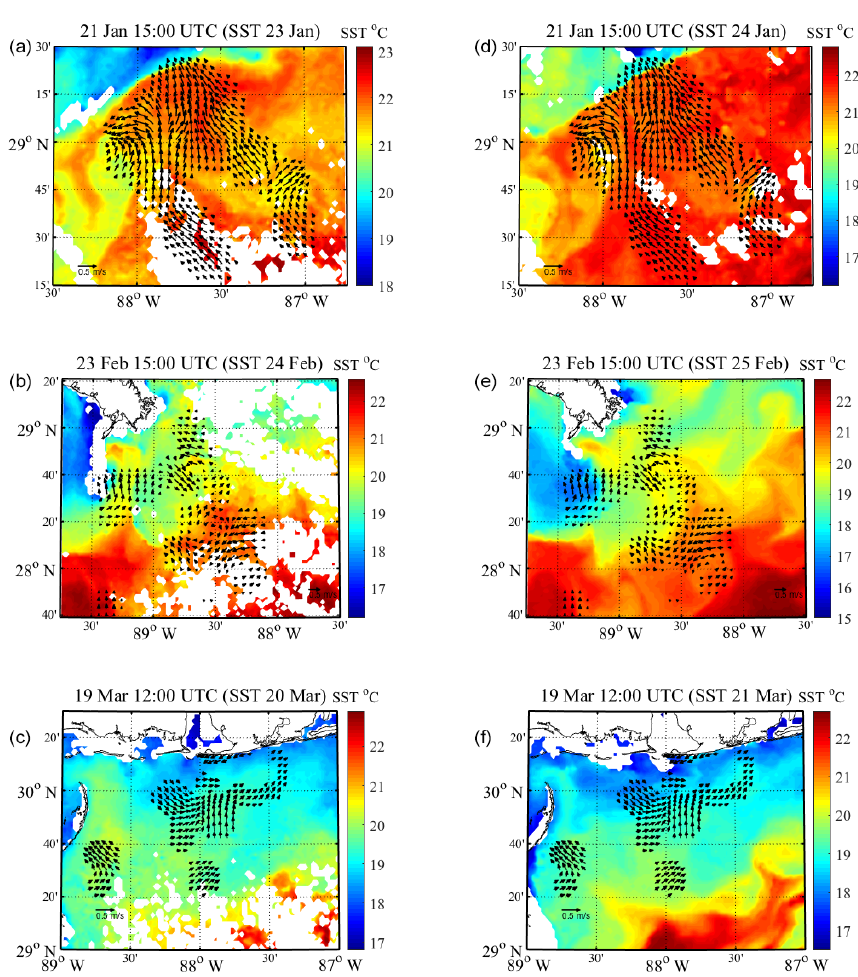
Figure 7. Eulerian velocity fields of the regional circulation that preceded each high wind event, created using LAVA for drogued drifters in the area. Also plotted are 24h averages of Aviso SST data during (a, b, c) and after (d, e, f) each high wind event. Titles of each plot list the beginning of each hour over which the velocity field was created from drifter trajectories and the day corresponding to the Aviso SST data. The 24h averages, produced by Aviso, are centered on 00:00UTC of the day listed. In each velocity field, every third vector is plotted for visibility. Velocity fields on the left and right side panels are